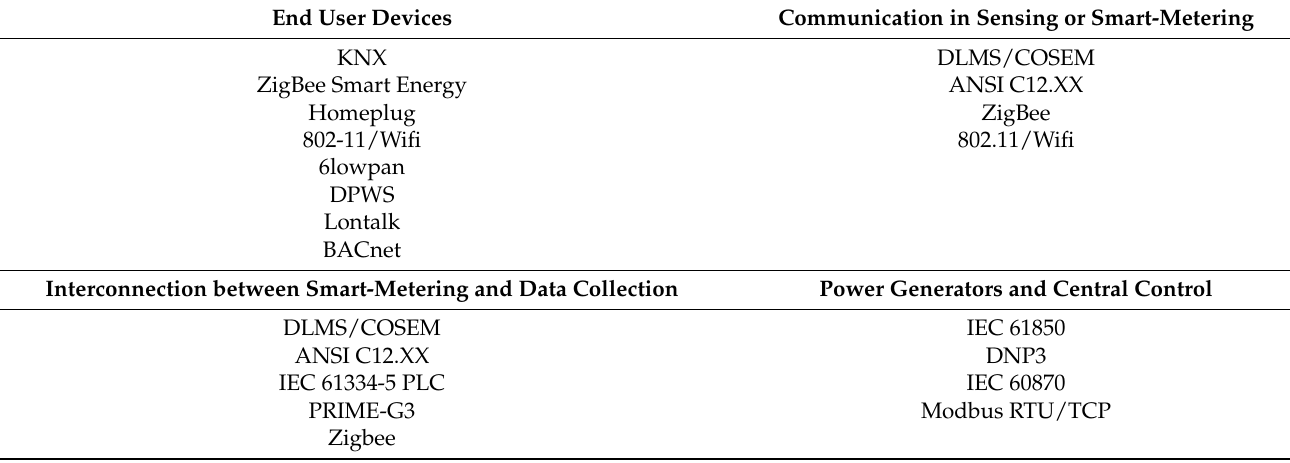
Table 3. Standards commonly used at different stages of a microgrid [34,35].